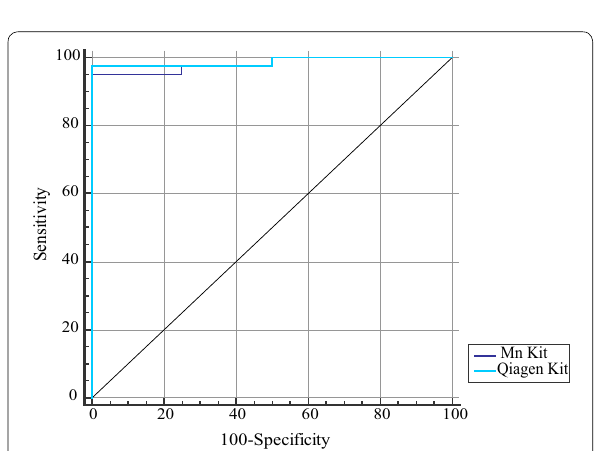
Fig. 3 ROC curve analysis for assessment of diagnostic power of cf DNA concentrations (ng/ml) for differentiation of metastatic